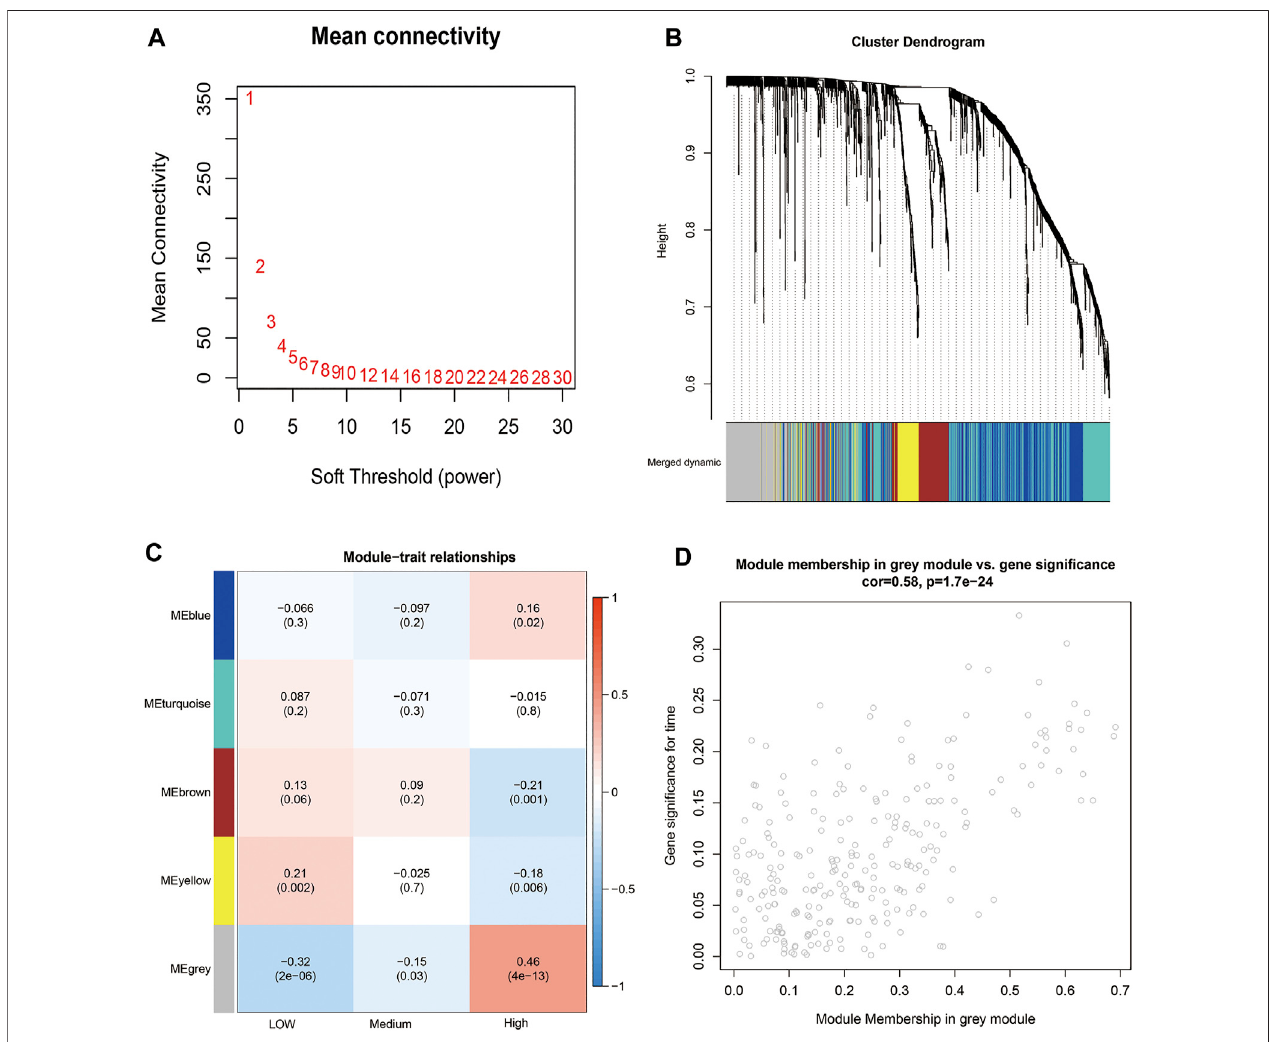
FIGURE6| WGCNA. (A) Analysisofthemeanconnectivityfordifferentsoft-thresholdpowers. (B) Clusterdendrogrambasedondynamictreecut. (C) Module – trait relationship plot. Each row corresponds to a module and column to TMB. (D) Scatterplot of gene signi fi cance versus module membership for the grey module.